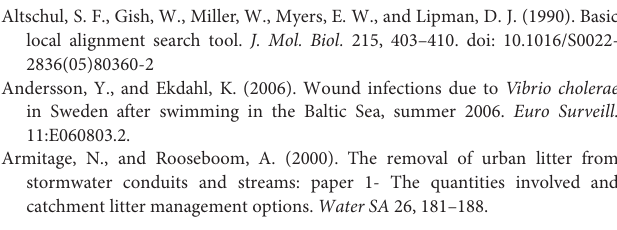
FIGURE S1 | Distribution of the average seawater surface temperatures at Port-Hacking. TABLE S1 | Sample location and environmental associated